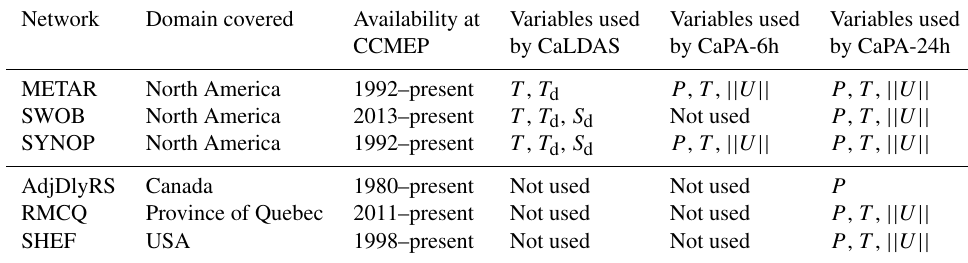
Table 3. Surface networks and variables used by CaLDAS and CaPA. Network Domain covered Availability at Variables used Variables used Variables used CCMEP by CaLDAS by CaPA-6h by CaPA-24h METAR North America 1992–present T , T d P , T , || U || P , T , || U || SWOB North America 2013–present T , T d , S d Not used P , T , || U || SYNOP North America 1992–present T , T d , S d P , T , || U || P , T , || U || AdjDlyRS Canada 1980–present Not used Not used P RMCQ Province of Quebec 2011–present Not used Not used P , T , || U || SHEF USA 1998–present Not used Not used P , T , || U